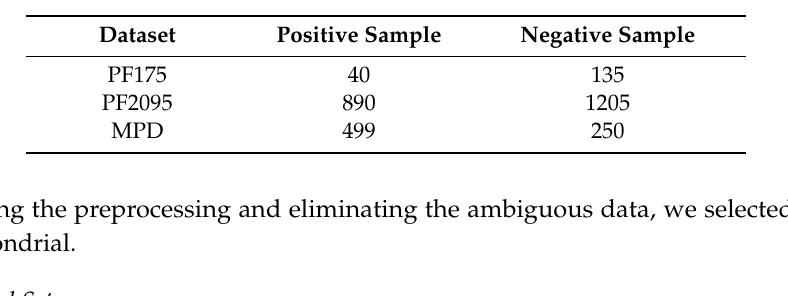
Table 2. Plasmodium falciparum mitochondria protein